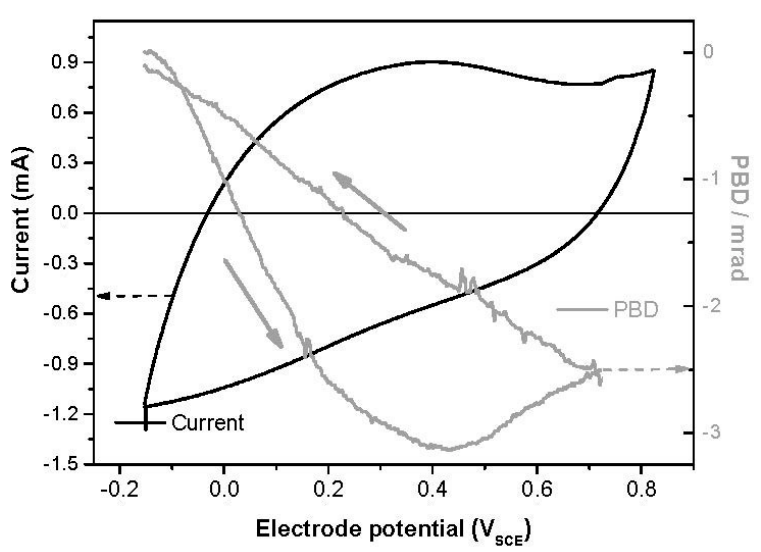
Figure 9. Cyclic voltammogram (black line) and deflectogram (grey line) of a composite mesoporous carbon in aqueous media (1 M H 2 SO 4 ). Scan rate = 0.7 mVs − 1 . Dashed arrows point to the axis of the measurement. Thick full arrows show the sense of PBD signal change.